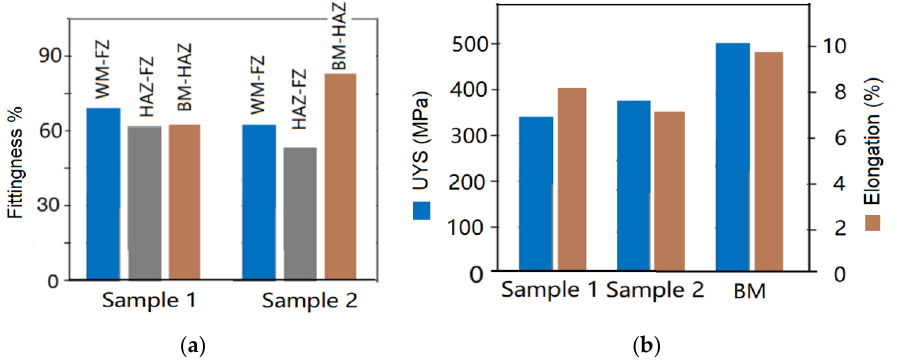
Figure 9. ( a ) Results of the statistical analysis of the fittingness between microstructures and performances of each zone of joints and ( b ) mechanical properties of samples.